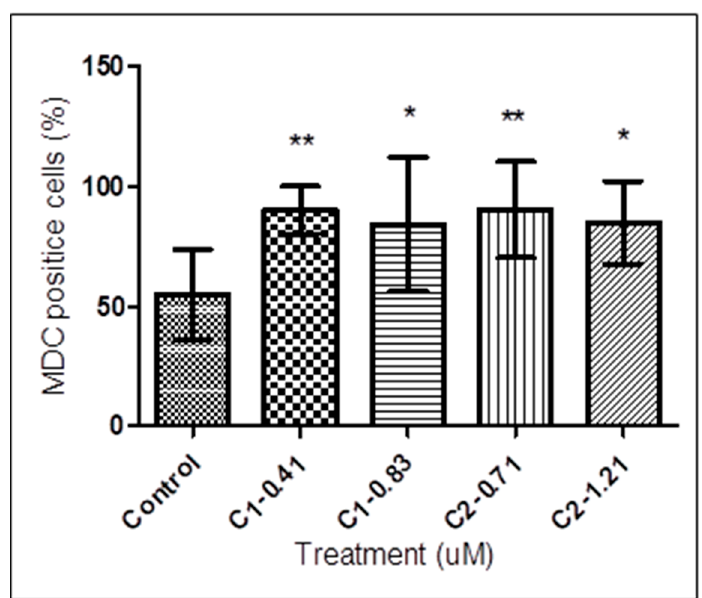
Figure 6. MDC labeling quantification of 1- and 2-treated T. b. rhodesiense . Treated and untreated trypanosomes were exposed to 1 at 0.41 and 0.83 μ M and 2 at 0.71 and 1.21 μ M for 72 h, stained with MDC (0.05 mM) for 10 min, normalized by staining with EtBr. The fluorescence signal was measured on a fluorometer. Trypanosomes treated with 0.41 and 0.83 μ M of 1 resulted in increment of MDC positive cells from 56.21 ± 20.85% (control) to 90.40 ± 10.02% and 85.01 ± 27.94%, respectively. On the other hand, treatment with 0.71 and 1.21 μ M of 2 induced increment of MDC positive cells to 90.29 ± 20.00% and 77.39 ± 17.25%, respectively. Data are presented as means ± SD from triplicates over three other independent experiments. The asterisks indicate significant differences between the treated and untreated groups, calculated by one-way ANOVA with Tukey post-test (* p < 0.05, ** p < 0.01). C, compound.